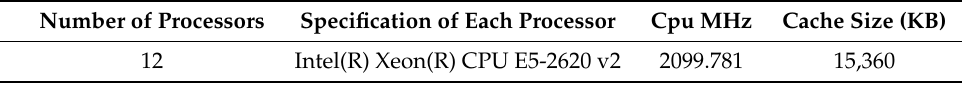
Table 7. Specifications of a computing node in the HPC (High Performance Computing) cluster.